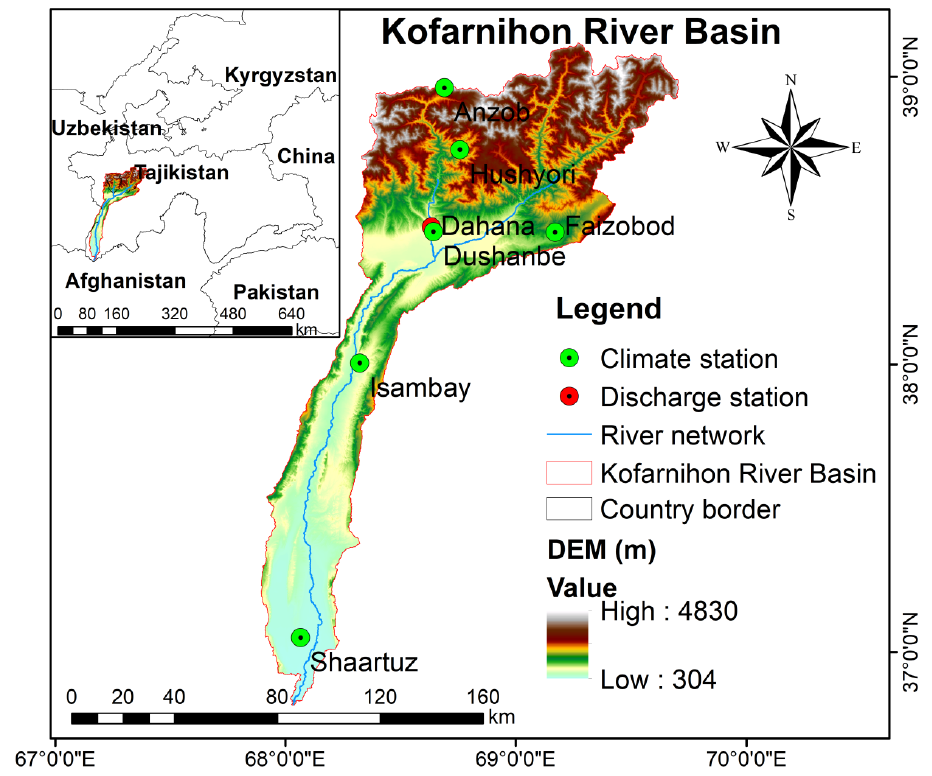
Figure 1. The geographical position and the distribution of the meteorological stations and hydrological station in the study